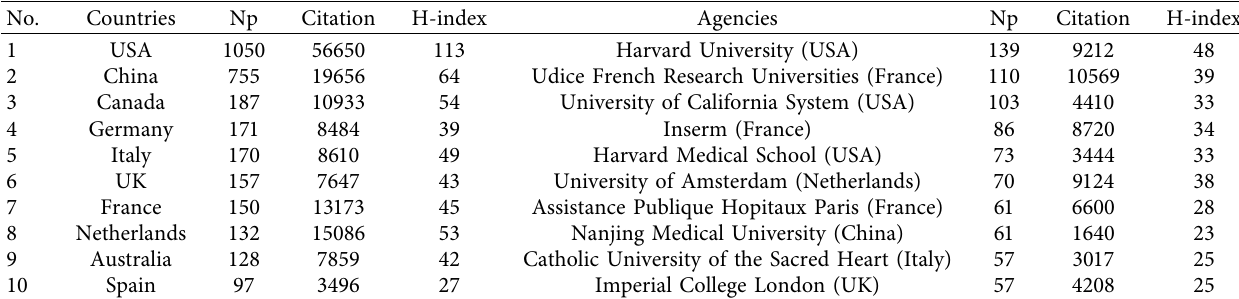
Table 3: Te top 10 high-yield countries and agencies in FMT